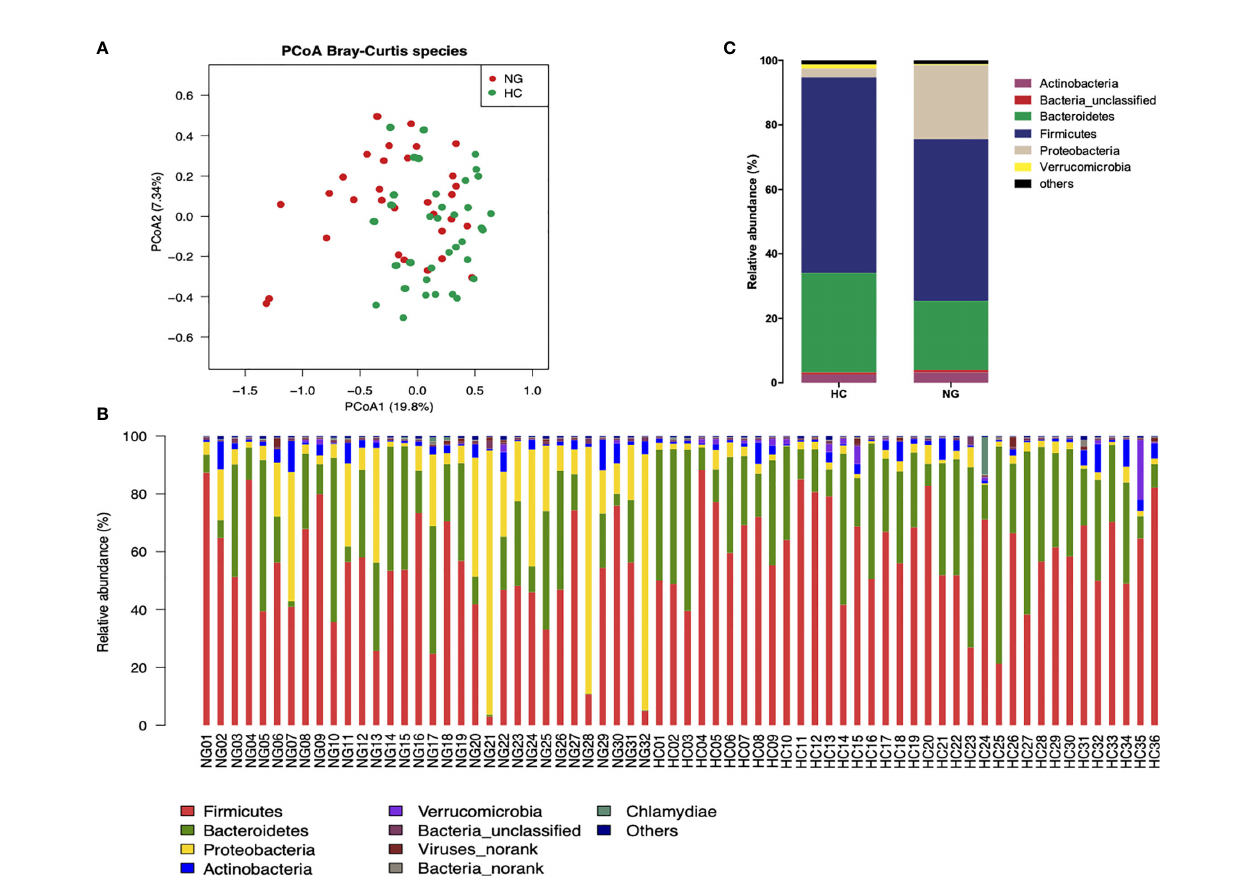
FIGURE 1 | Differences in the fecal microbiota composition of children with NAFLD (NG) and heathy control (HC) children. (A) Principal-coordinate analysis (PCoA) of a Bray-Curtis distance generated from fecal bacterial taxa shown at the species level. (B) Phyla distribution of gut microbiota in the NAFLD (n=32) and HC (n=36) children. The distribution of gut bacterial phyla (abundance >1%) of each sample is shown as a bar chart in terms of percentage weight. (C) Average relative abundance of gut microbiota at the phylum level in NG (n=32) and HC (n=36)